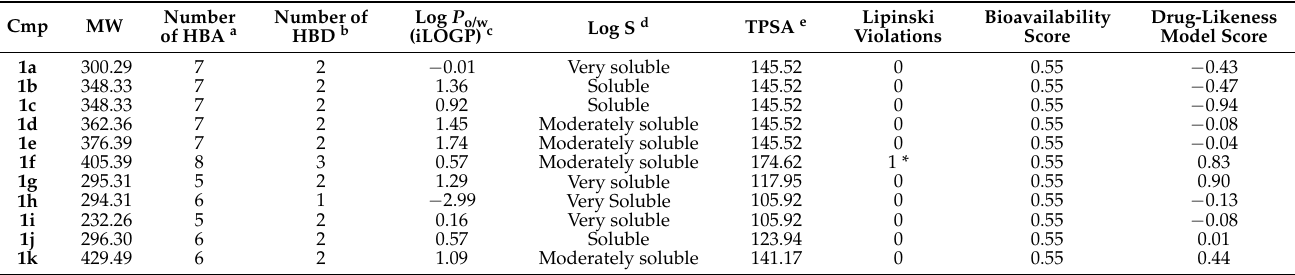
Table 6. Drug-likeness predictions of tested